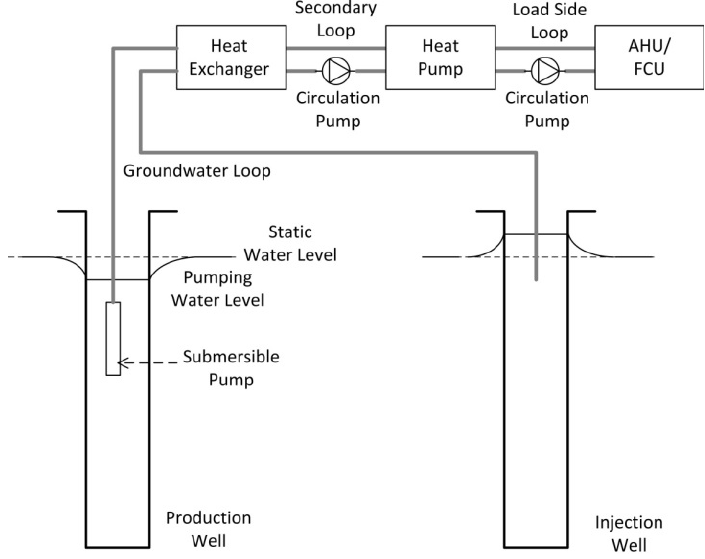
Figure 2. Groundwater heat pump system layout.